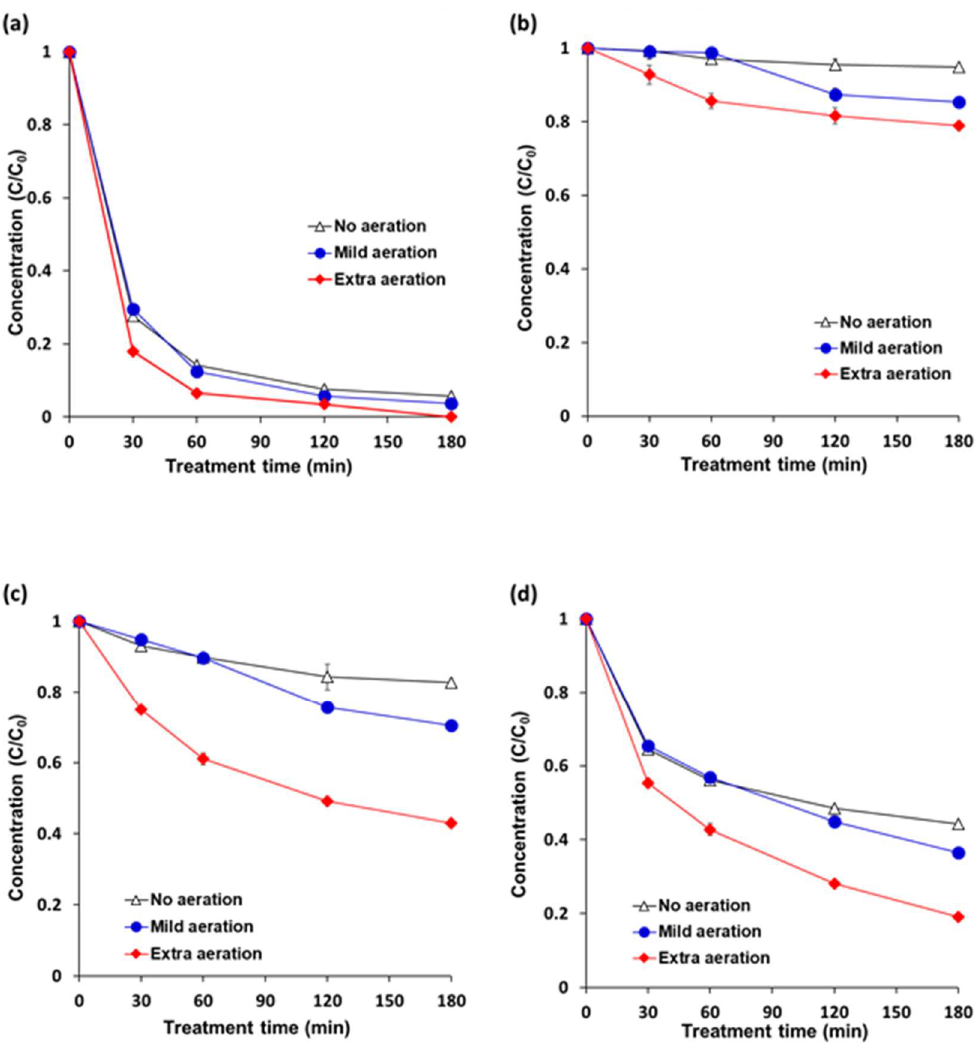
Figure 4. E ff ects of air bubble induced agitation on the pesticide degradation e ffi ciency under VUV-assisted TiO 2 photocatalytic treatment (VUV-TiO 2 ). ( a ) pyraclostrobin; ( b ) boscalid; ( c ) fludioxonil; and ( d ) azoxystrobin. A cocktail solution was composed of individual pesticides at 5 ppm ( w / v ). No aeration = magnetic stirring at 300 rpm; mild aeration = air flow rate of 1.8 L / min with magnetic stirring at 300 rpm; and, extra aeration = air flow rate of 20 L / min with magnetic stirring at 300 rpm. Results represent the mean of three measurements ± standard